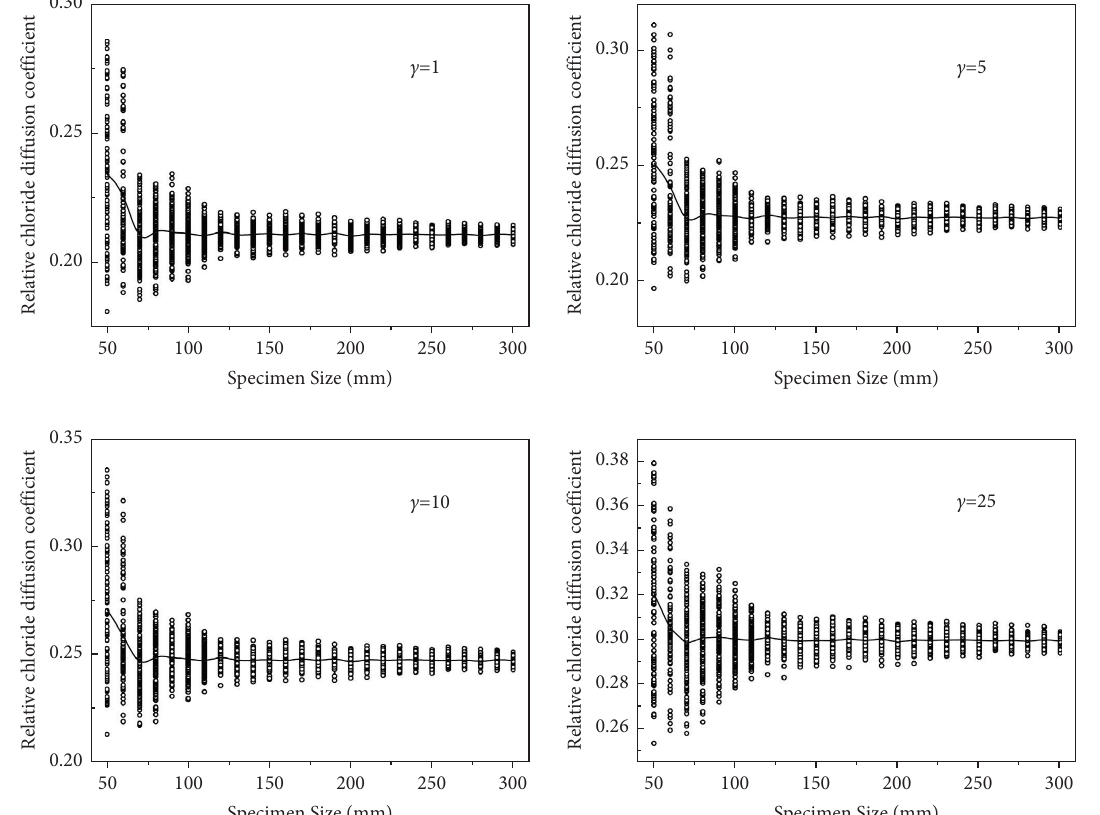
Figure 6: Relative chloride’s difusion coefcients in concrete at diferent sizes ( k � 0 . 08).